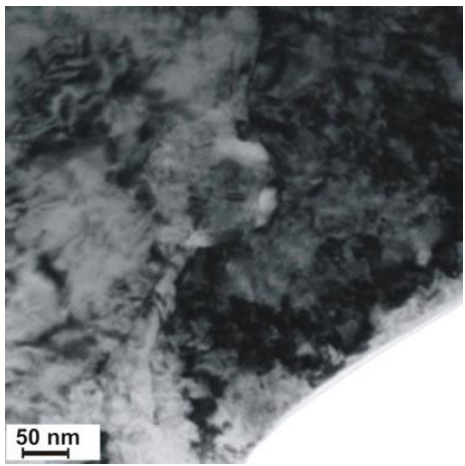
Figure 17. Precipitation of nitride (Ti,Nb)N in the S700MC steel (marked with an arrow) laser welded joint in the PC position with 5 kJ/cm linear energy.